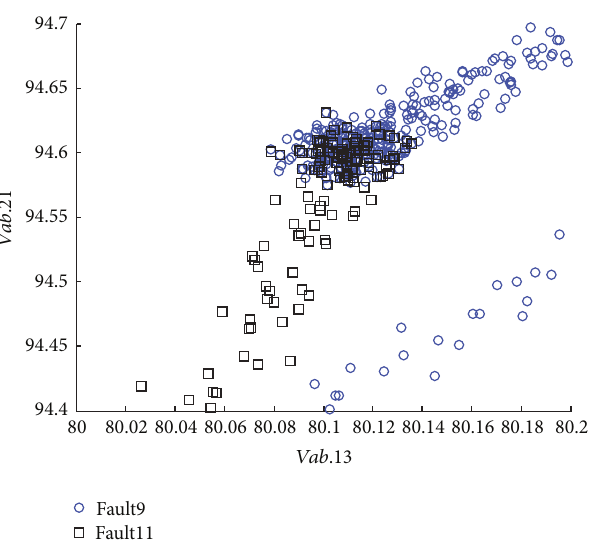
Figure 5: The distribution of Fault9 and Fault11, described in 2- dimension diagram with 𝑥 -axisofprocess variable Vab .13 and 𝑦 -axis of process variable Vab .21 .